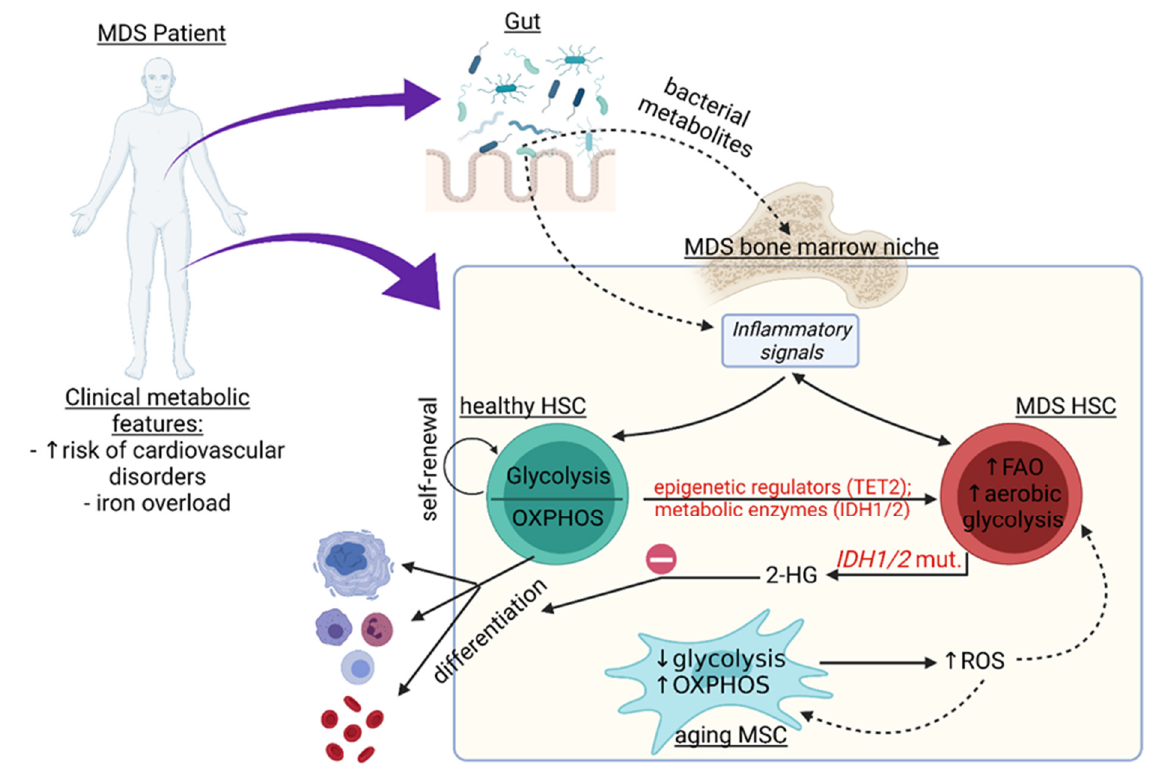
Figure 1. Metabolic changes in myelodysplastic syndromes (MDS). Patients with MDS clinically demonstrate the propensity to develop cardio-metabolic disturbances, such as cardiovascular disorders and iron overload. Various cellular and molecular mechanisms are responsible for the metabolic changes in these patients. Whereas the healthy hematopoietic stem cells (HSC) preferentially engage in glycolysis for their self-renewal, differentiation to mature blood cells is linked with oxidative phosphorylation (OXPHOS). MDS HSC increase the level of aerobic glycolysis and fatty acid oxidation (FAO). At least in part, epigenetic regulators, such as TET2, and metabolic enzymes, such as IDH1/2, regulate the shift in metabolic pathways; for example, the oncometabolite 2-hydroxyglutarate (2-HG) accumulates in IDH1/2 mutated cells. Regulation of such metabolic pathways may be involved in the ineffective erythropoiesis in MDS. Furthermore, the deterioration of MSC function in aging patients, accompanied by decreased glycolysis and increased OXPHOS, is associated with increased production of ROS by MSC, which are, in turn, capable of modifying proteins, lipids, and DNA in both MSC and HSC, leading to further expansion of the malignant clone. A possible role of bacterial metabolites from the gut microbiome in the maintenance of chronic inflammation and related metabolic changes in the bone marrow niche is conceivable.